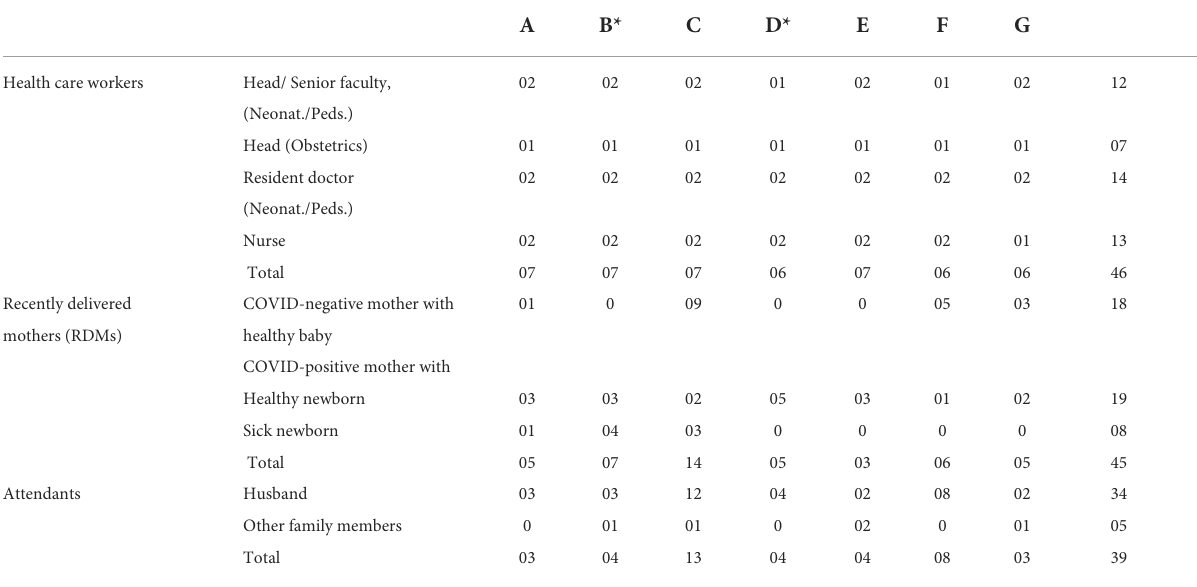
TABLE 1 Distribution of participants from the study sites ( n =